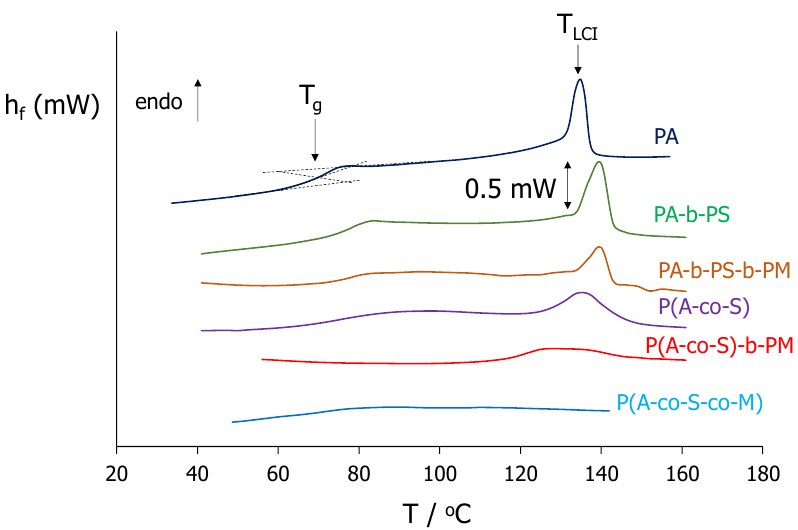
Figure 3. Differential scanning calorimetry (DSC) thermograms obtained in the second heating scan of polymers containing MeOAzB and AMPS groups. The mesogenic homopolymer (PA) has been included for the sake of reference. Curves have been shifted arbitrarily along the Y-axis (h f , heat flow). PA-b-PS, PA-b-PS-b-PM and P(A-co-S) form liquid crystalline phases on cooling from their